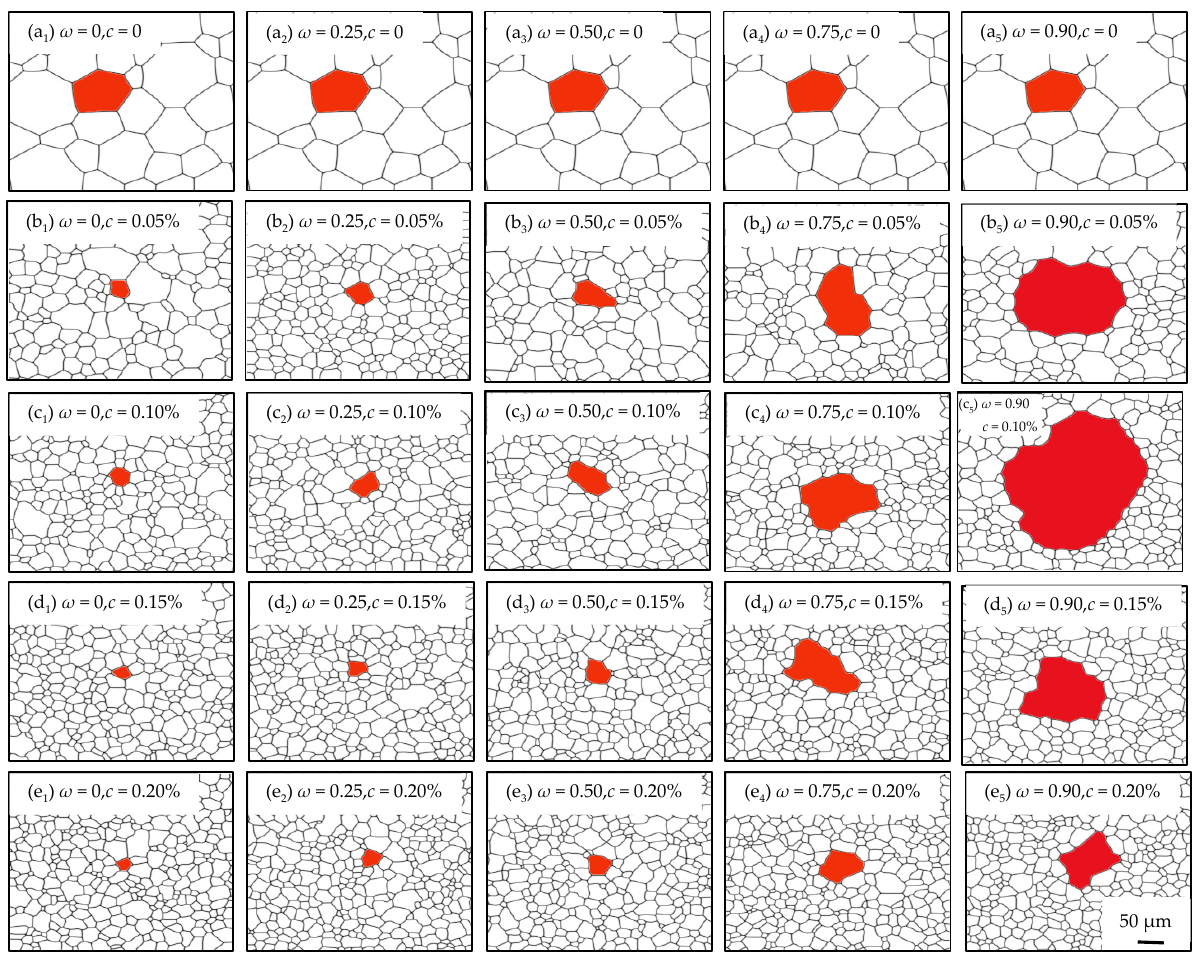
Figure 12. Microstructure evolution at 100 min under various combinations of c and ω s at 1273 K. ( a 1 – a 5 ) c = 0, ω = 0-0.90;( b 1 – b 4 ) c = 0.05%, ω = 0-0.90; ( c 1 – c 4 ) c = 0.10%, ω = 0-0.90; ( d 1 – d 4 ) c = 0.15%, ω = 0-0.90; ( e 1 – e 4 ) c = 0.20%, ω = 0-0.90.